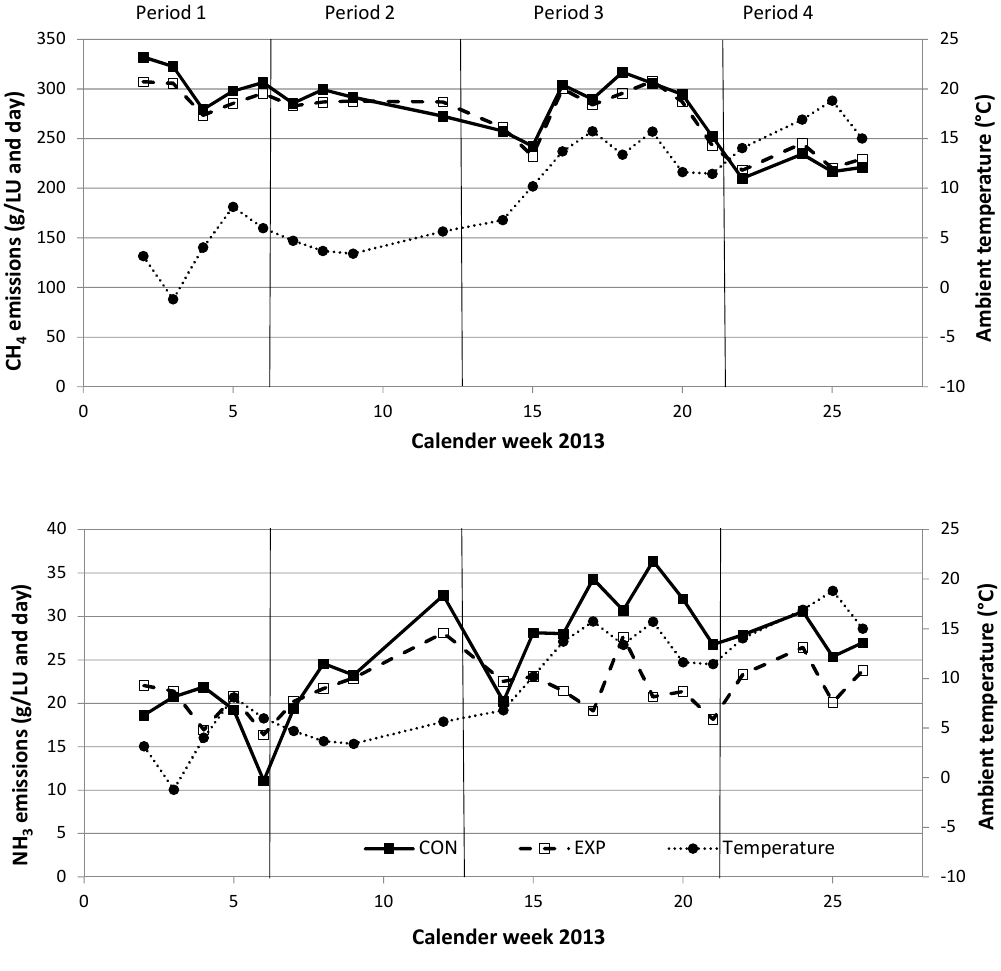
Figure 5. Methane and ammonia emissions of the control (CON; ■ ) and experimental (EXP; □) groups during four investigation periods (subdivided by vertical bars) with different ambient temperatures (●). Different feed rations are marked with a vertical bar. Data points show weekly means calculated from hourly means (see Section 3.2). Table 2. Barn level CH 4 and NH 3 emissions averaged over the feeding periods. GHG: greenhouse gases.